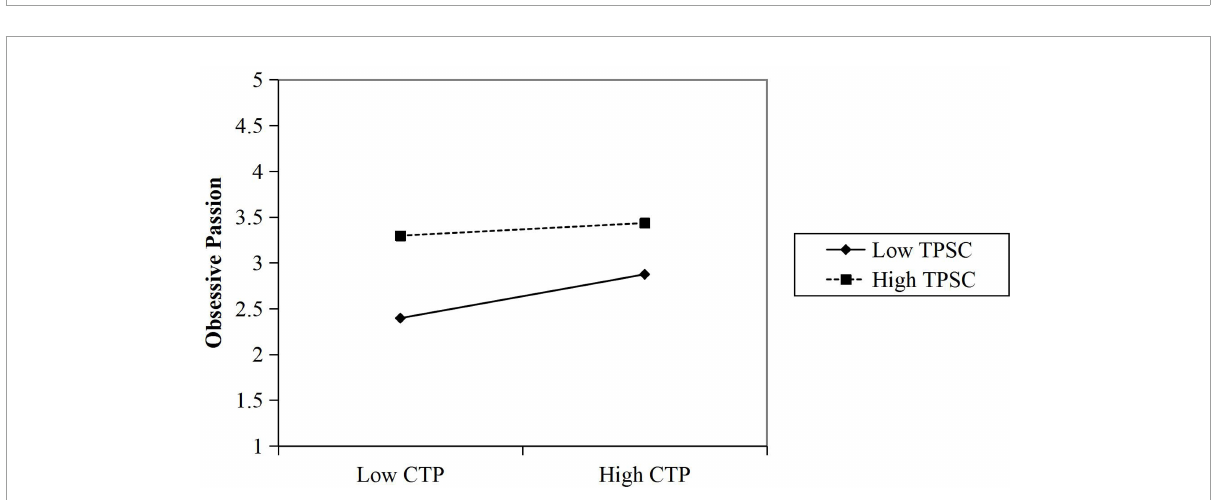
FIGURE3 The moderating effect of team psychological safety climate (TPSC) on the relationship between creative time pressure (CTP) and obsessive passion.